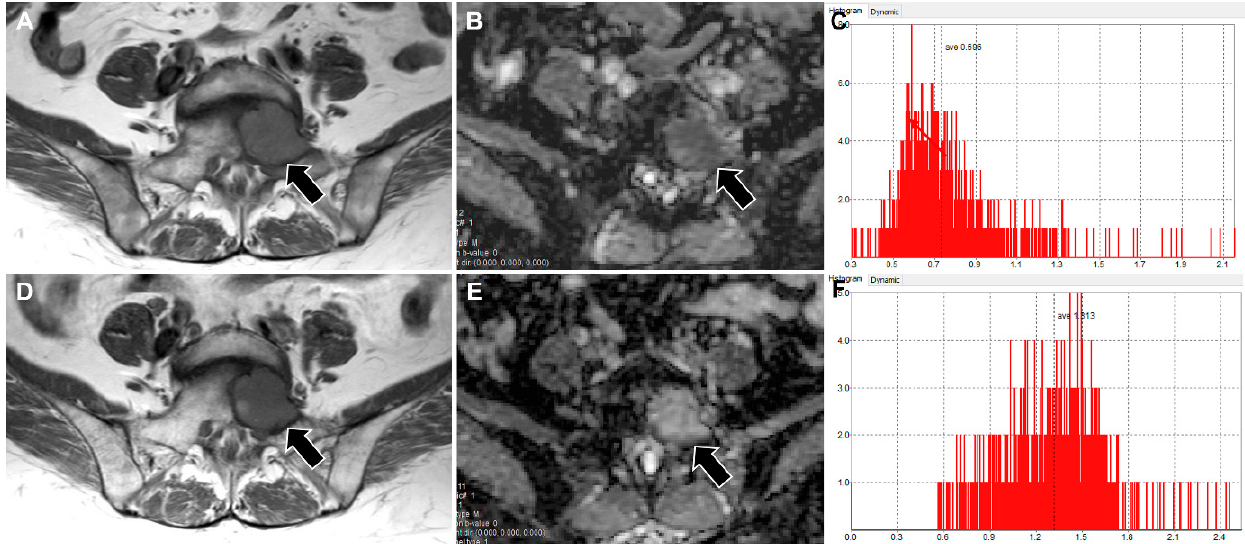
Figure 3. Images of a 72-year-old woman with metastasis to the S1 vertebra from a thyroid cancer.